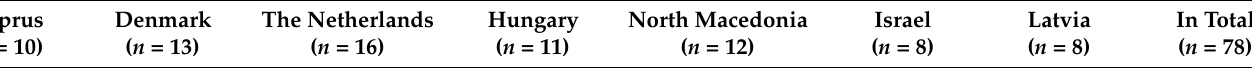
Table 3. Categories and subcategories identified during the research